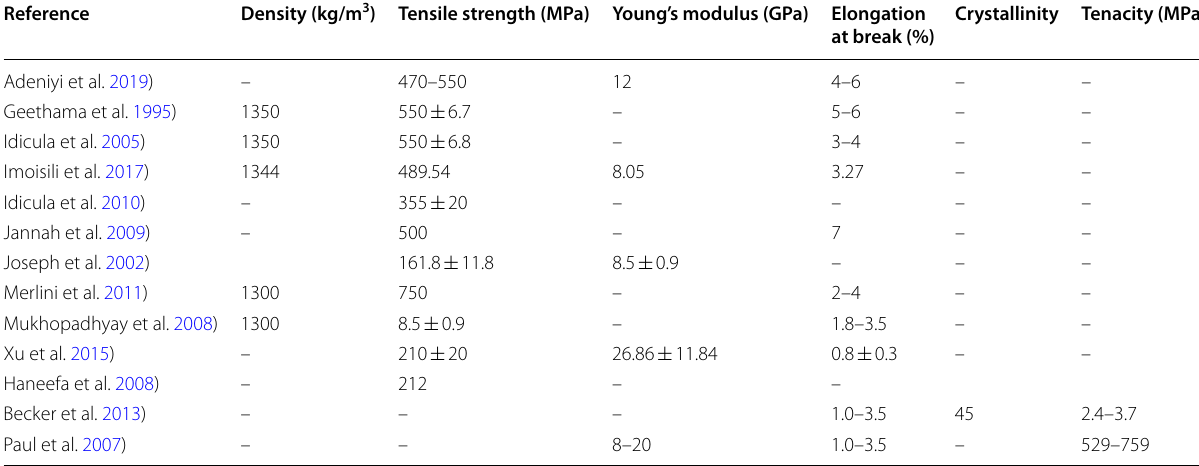
Table 4 Physicomechanical properties of isolated Musa spp. fibres (Rao and K. and MohanaRao et al. 2007; Alavudeen et al. 2015)